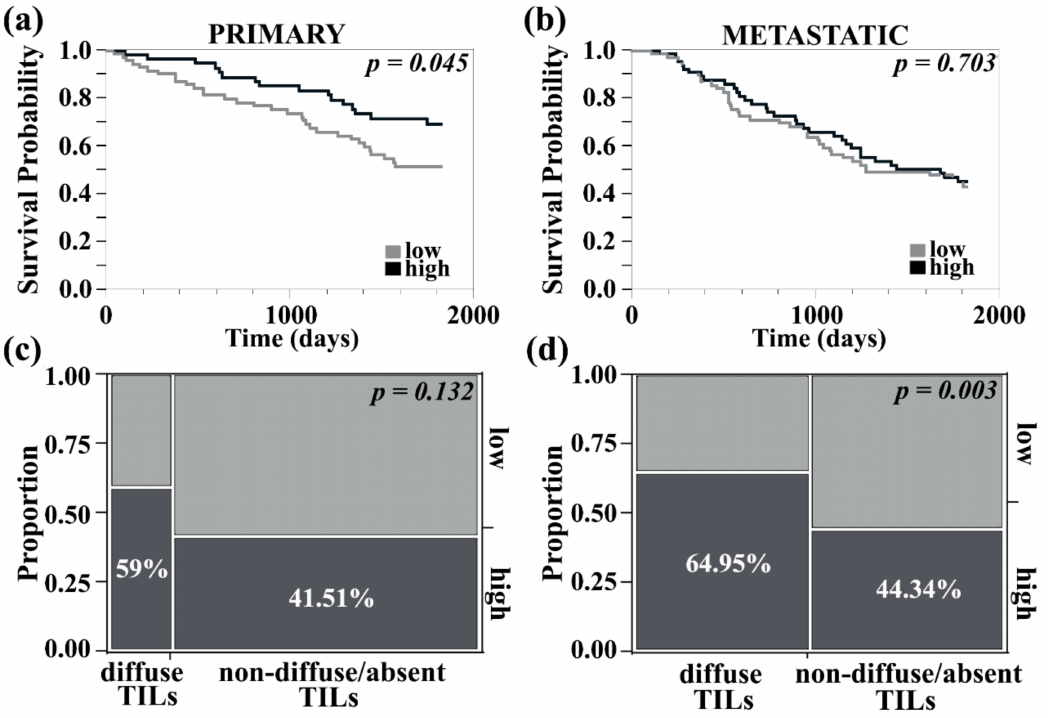
Figure 3. PDCD4 expression in the tumor stroma of primary and metastatic melanoma. ( a ) High PDCD4 expression in primary tumor stroma had improved 5-year survival. ( b ) High PDCD4 expression in metastatic tumor stroma did not impact 5-year survival. ( c ) Stromal PDCD4 was dichotomized into high/low groups and compared with stromal tumor-infiltrating leukocyte quantity (either brisk/diffuse vs. non-diffuse/absent). A trend towards significance was seen between high stromal PDCD4 and brisk/diffuse TILs in primary tumors (Chi-square, p = 0.13). ( d ) There were significantly more cases of high stromal PDCD4 that had diffuse TILs in metastatic melanoma (Chi-square, p =